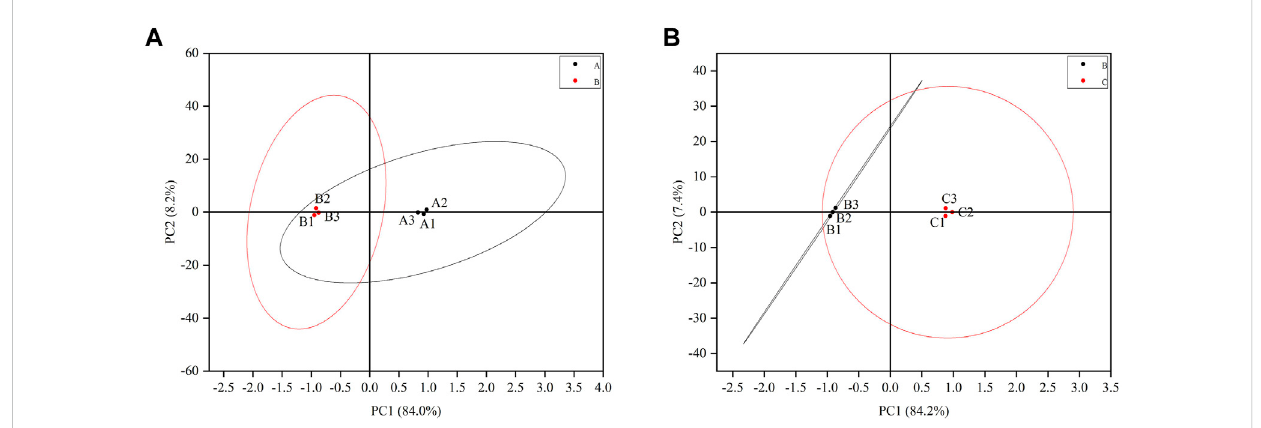
FIGURE 3 (A) Testicular PCA scores of male rats between the control and model groups. (B) Testicular PCA scores of male rats in the treatment and model groups. The letter A represents the control group, the letter B represents the model group, and the letter C represents the TSZSDH